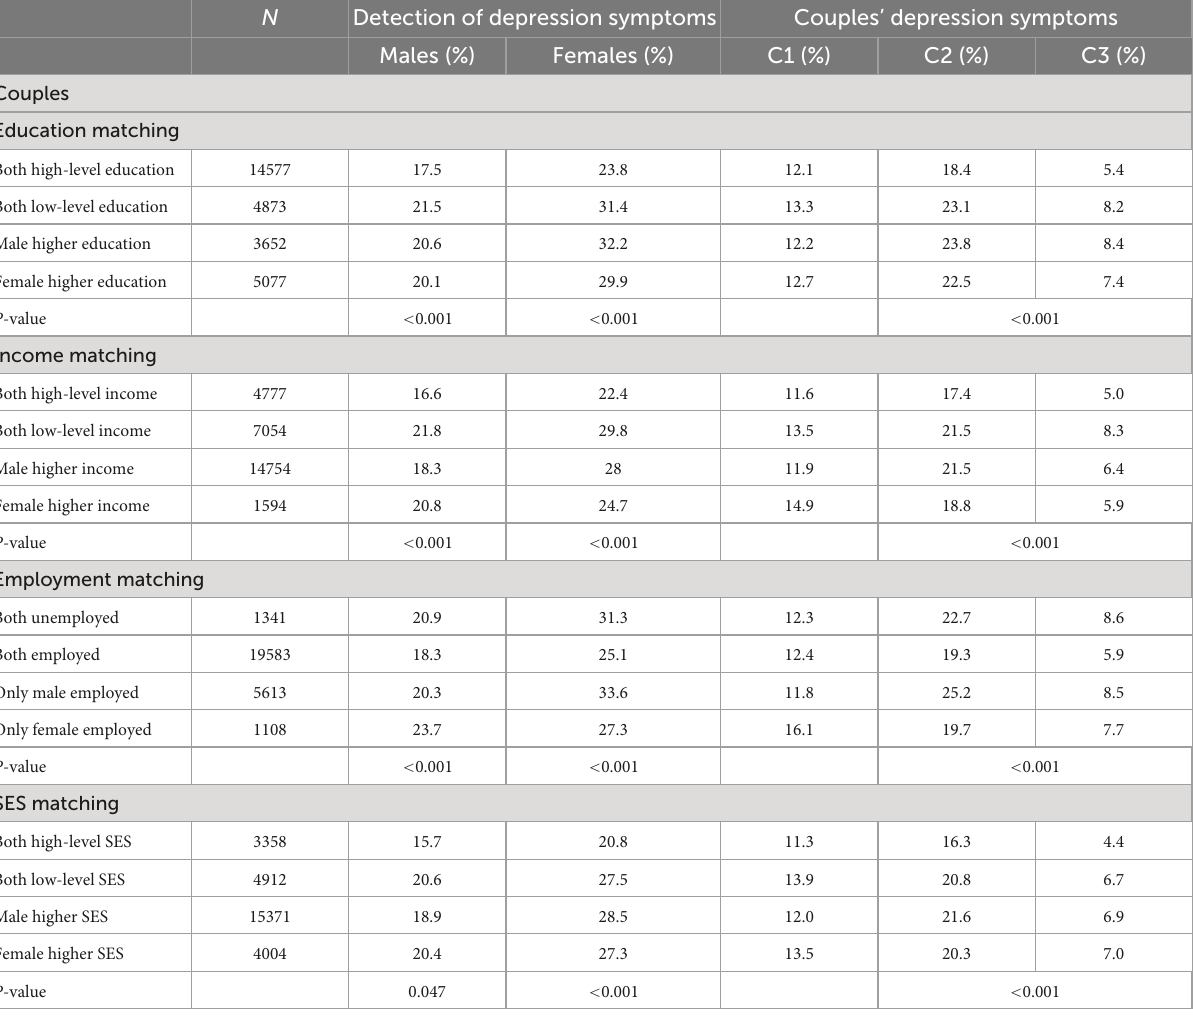
TABLE 2 Differences in socioeconomic status matching distribution between depressive symptoms. N Detection of depression symptoms Couples’ depression symptoms Males (%) Females (%) C1 (%) C2 (%) C3